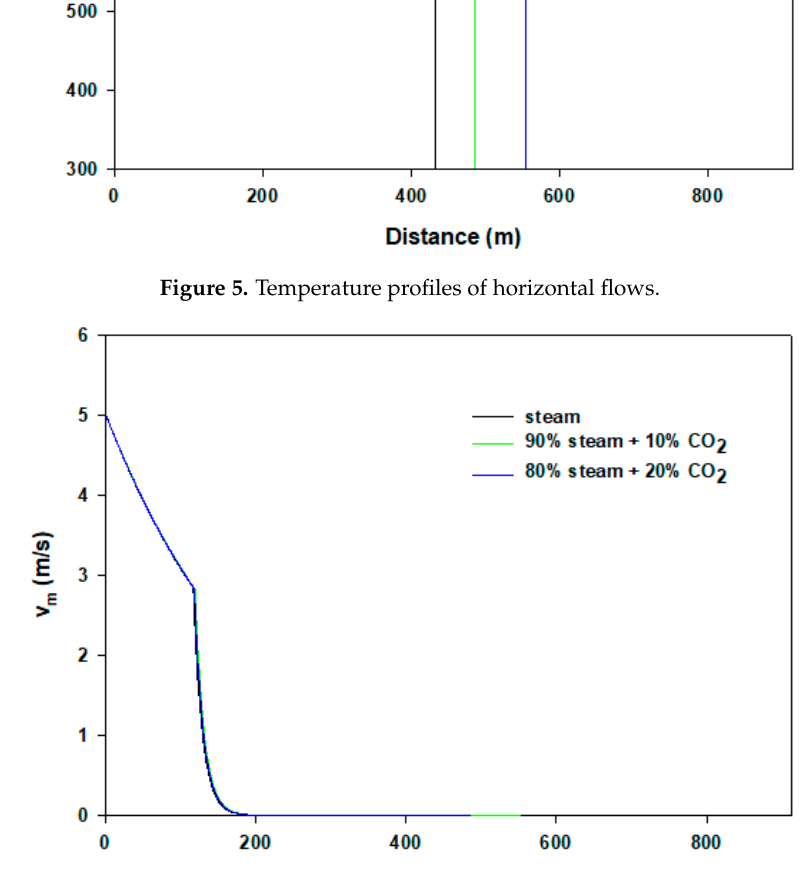
Figure 6. Velocity results of horizontal flows.